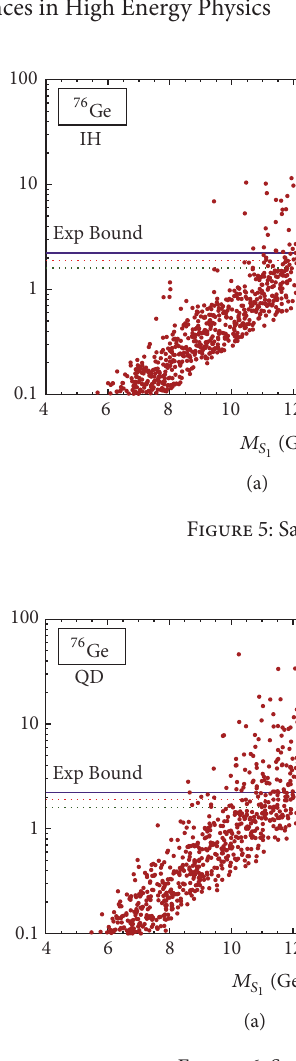
Figure 6: Same as Figure 4 but for quasi-degenerate (QD) type light neutrino masses.